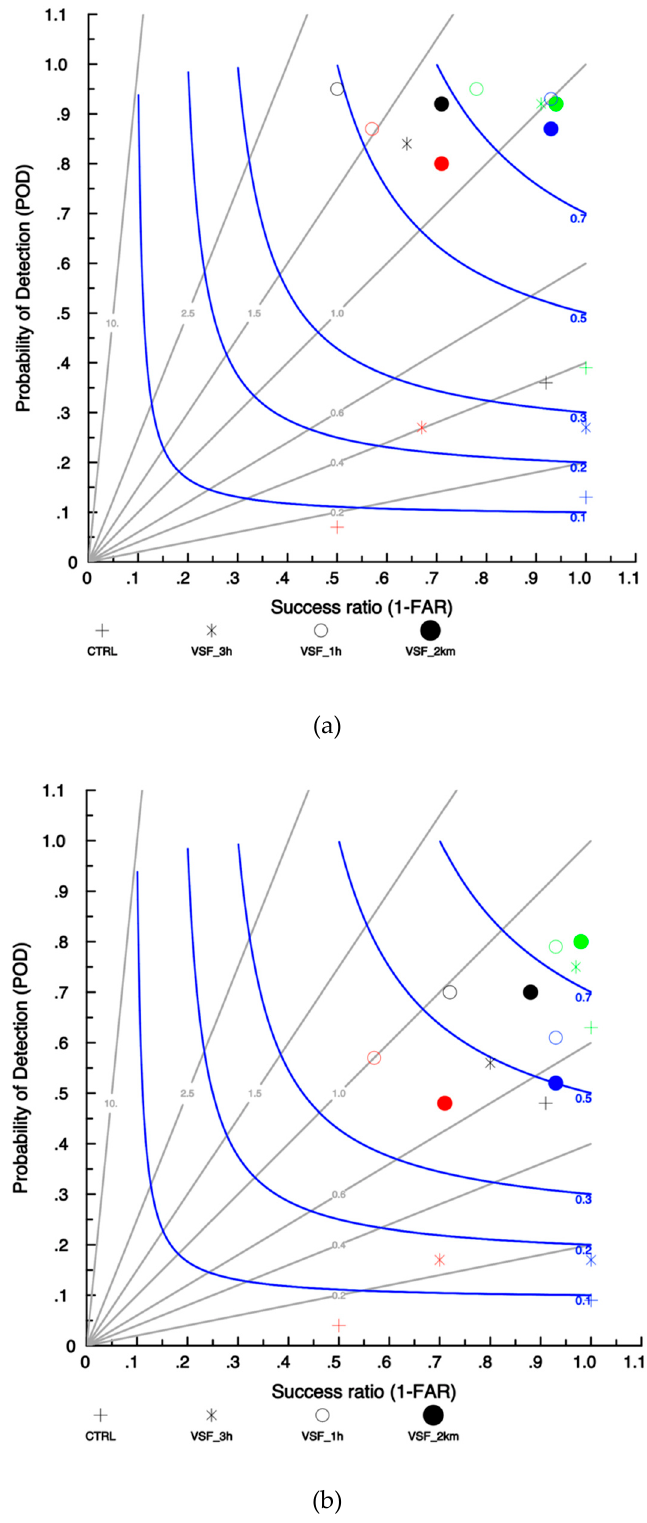
Figure 11. Performance diagram for the Sardinia rain gauges ( a ) and for the whole of Italy ( b ). Black markers are for the 10 mm / 3 h threshold and for 8.5 km nearest neighborhood, red markers are for the 50 mm / 3 h threshold and for 8.5 km nearest neighborhood, green markers are for the 10mm / 3 h threshold of the 20 km nearest neighborhood, and blue markers are for the 50 mm / 3 h threshold and 20 km nearest neighborhood.